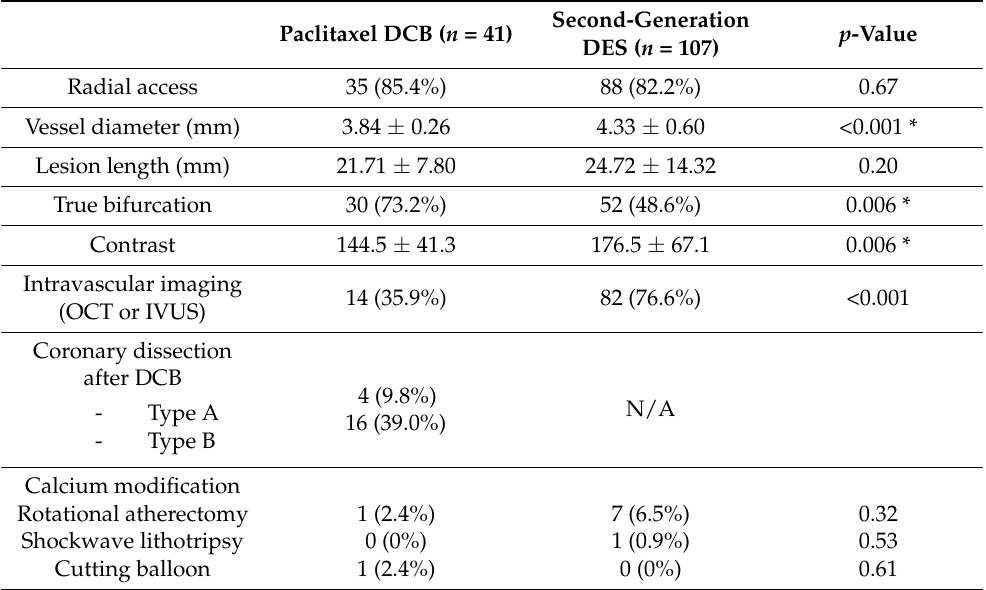
Table 2. Procedural characteristics of both patient